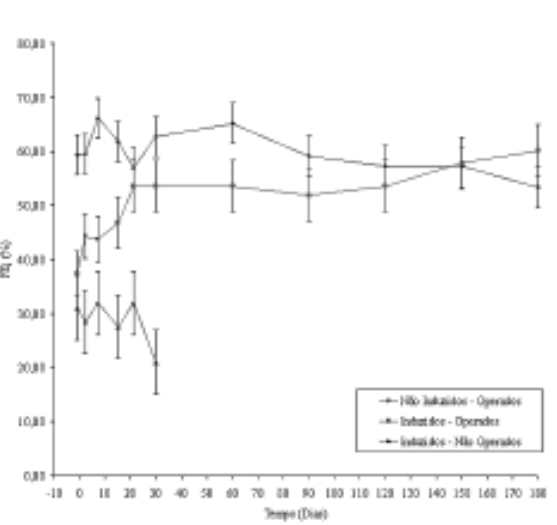
Fig. 6 – Fração de ejeção do ventrículo esquerdo (FEj), ao longo do tempo, de cães hígidos (n=5) ou com cardiomiopatia dilatada induzida pela doxorrubicina (n=4), submetidos à plicatura da parede livre do ventrículo esquerdo e cães induzidos não operados